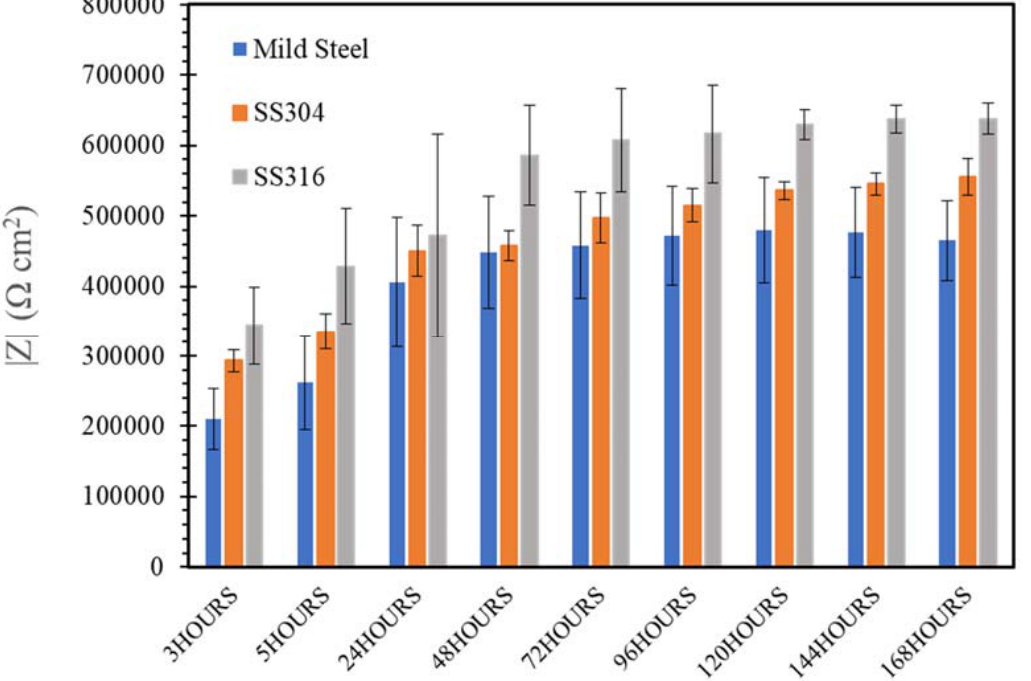
Figure 11. Evolution of impedance |Z| for of mild steel, SS304 and SS316 in HPC solution.